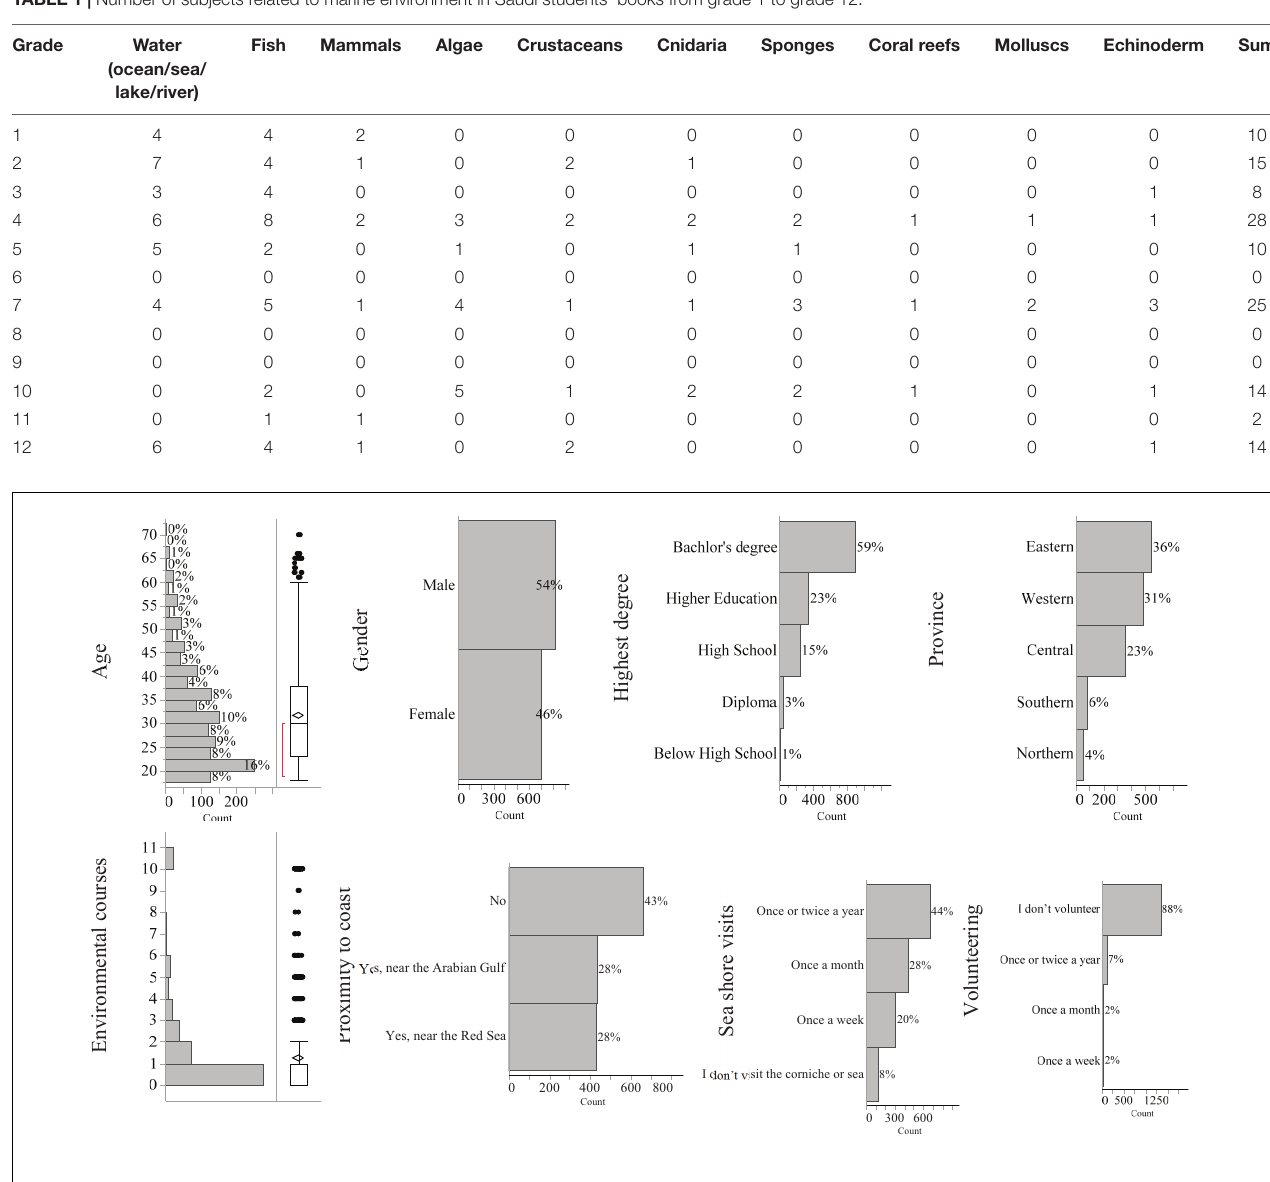
FIGURE 1 | Demographics, gender, education, and geographic distributions of Saudi citizens. TABLE 2 | Total number of responses after rebalancing the received interviews. Number of